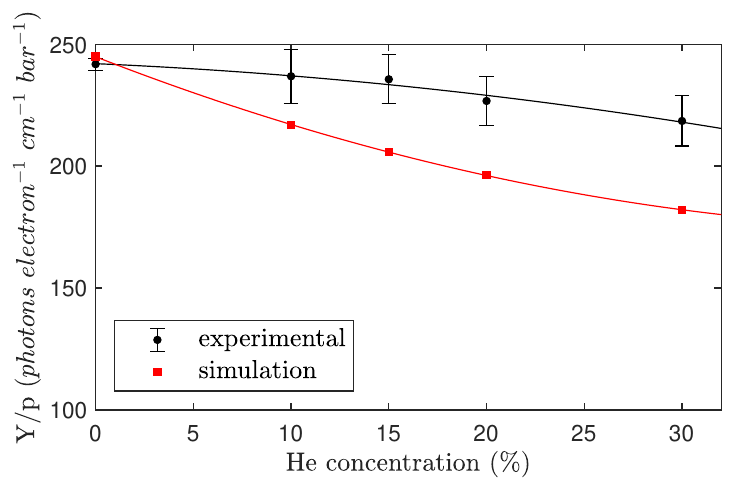
Figure 9 . Reduced electroluminescence yield as a function of He-concentration for a reduced electric (cid:12)eld of 2.5 kV/cm/bar.